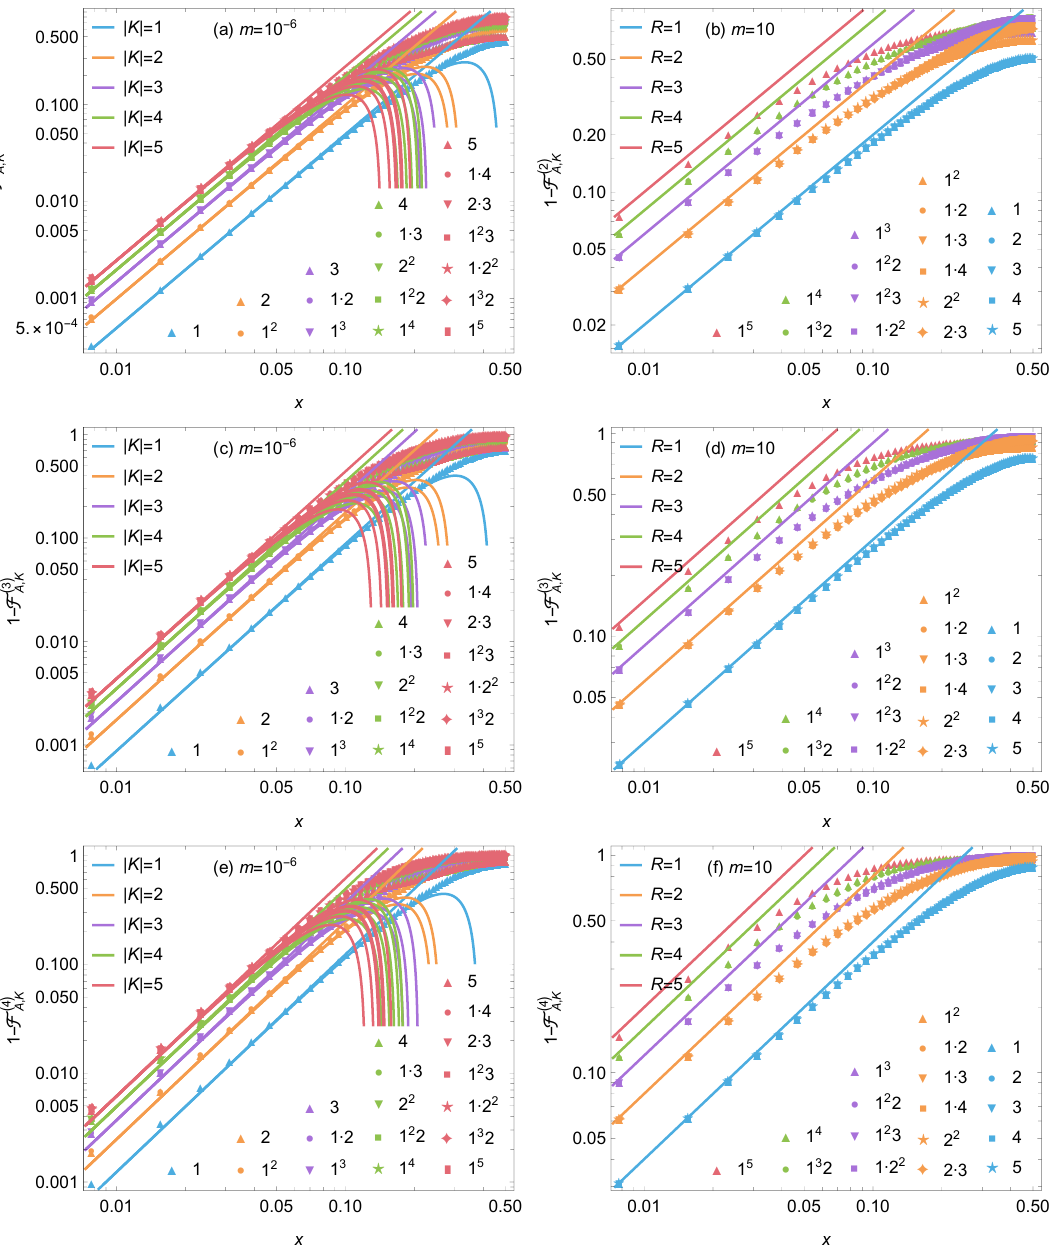
Figure 3 . The short interval expansion of the excited state Rényi entropy in the massless (left column) and extremely massive (right column) limits of the 2D free non-compact bosonic theory (lines) and the excited state Rényi entropy in the gapless (left column) and extremely gapped (right column) limits of the harmonic chain (symbols). In the left column, we show not only the short interval expansion results to the leading nontrivial order x 2 (straight lines), but also the results to the next-to-leading order x 4 (curved lines). We have set L = 128